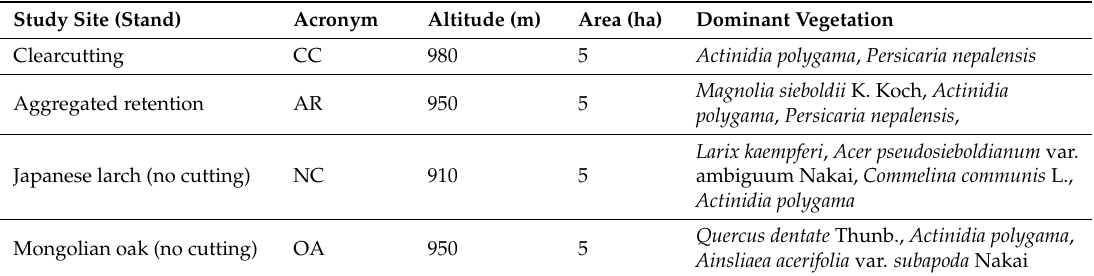
Table 1. Characteristics of environmental factors at each study